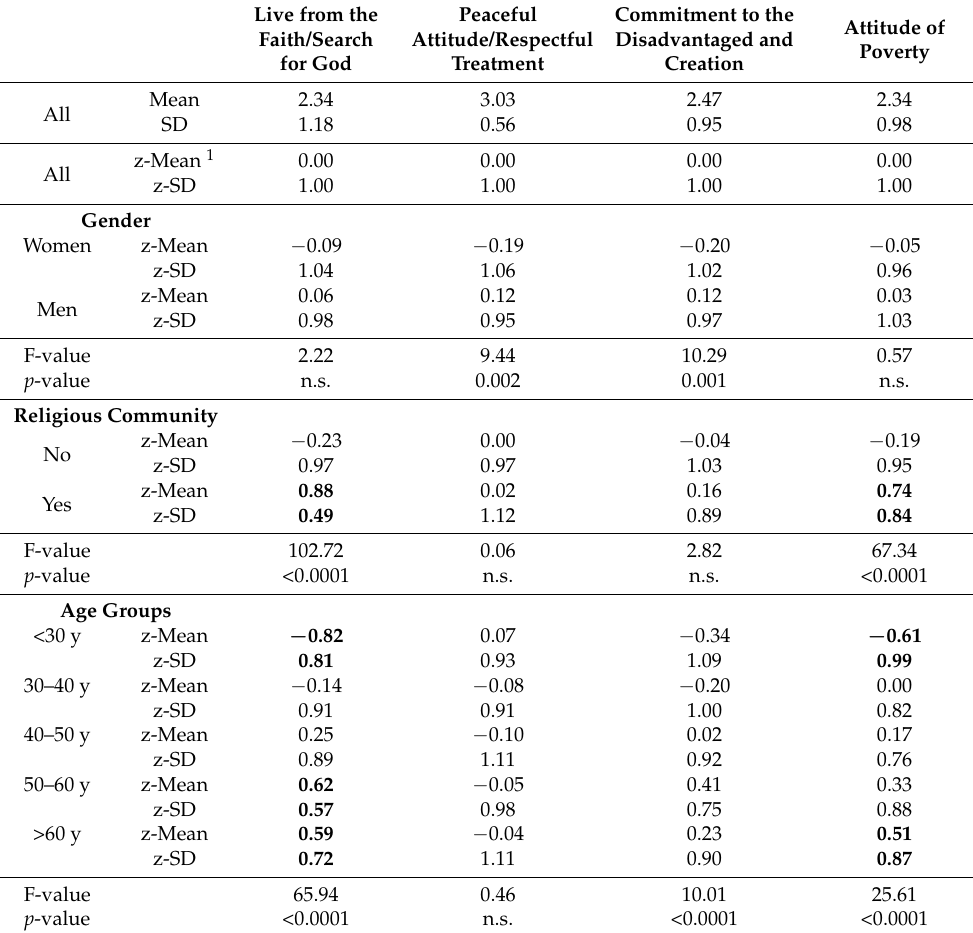
Table 3. Mean score values of Franciscan-inspired spirituality (FraSpir) subscales. Live from the Peaceful Commitment to the Faith/Search Attitude/Respectful Disadvantaged and for God Treatment